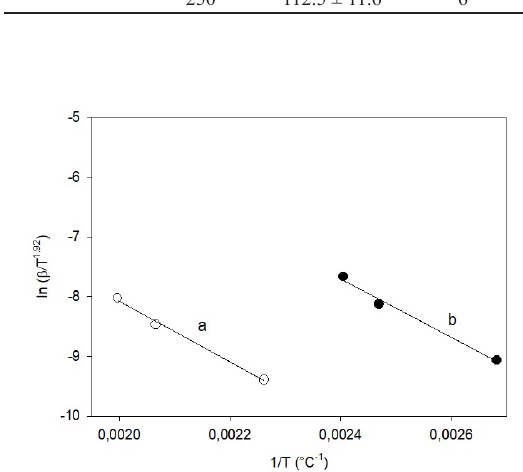
Figure 3. Calculation of activation energy by Starink method from plot ln (β/T 1.92 ) versus 1/T come from thermogravimetry analysis (TGA) for unirradiated LLDPE composite carried out at 10, 30 and 50 °C.min -1 heating rates (β) and conversion rate x = 0.5 only, under a) ○ N (E = 41.8 kJ/mol; r 2 = 0.995) and b) ● O 2 a kJ/mol, r 2 = 0.989) atmospheres.